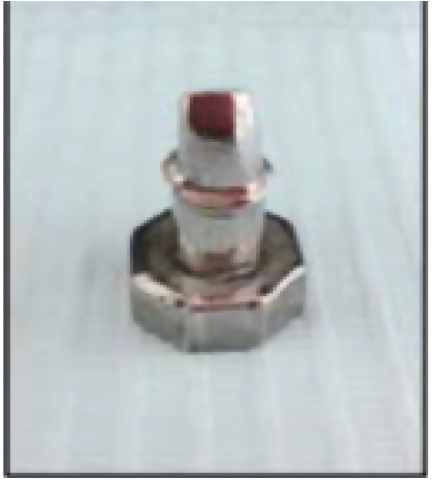
Figure 1: Stainless steel master